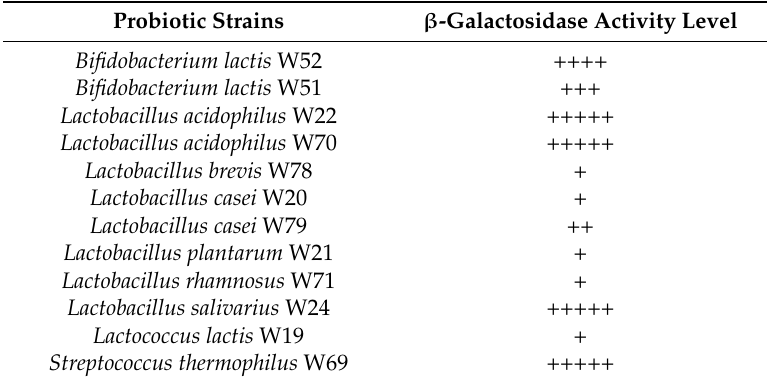
Table 4. The β -galactosidase activity of several probiotic strains (modified from [46]). Probiotic Strains β -Galactosidase Activity Level Bifidobacterium lactis W52 ++++ Bifidobacterium lactis W51 +++ Lactobacillus acidophilus W22